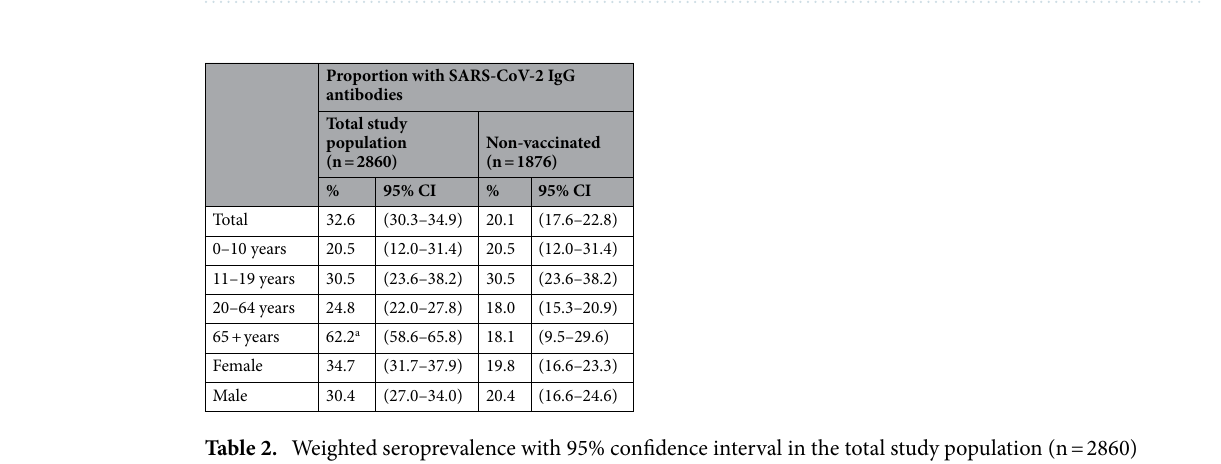
Table 1. Distribution of participants, vaccination status, and diagnosed cases, in total and by age group and sex. Sweden April 26–May 9, 2021 (n = 2860).